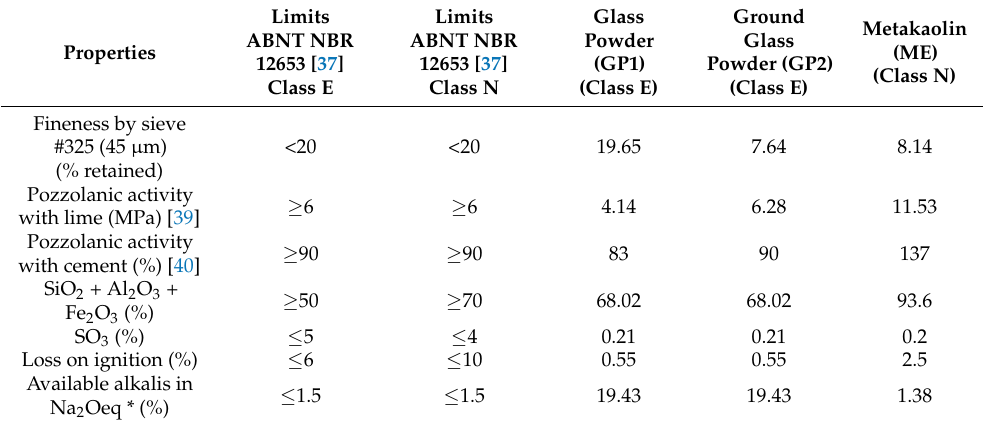
Table 2. Limits for the classification of pozzolanic materials according to NBR 12653 [37]; results were obtained in the laboratory by the authors and detailed in Guignone et al. [38].